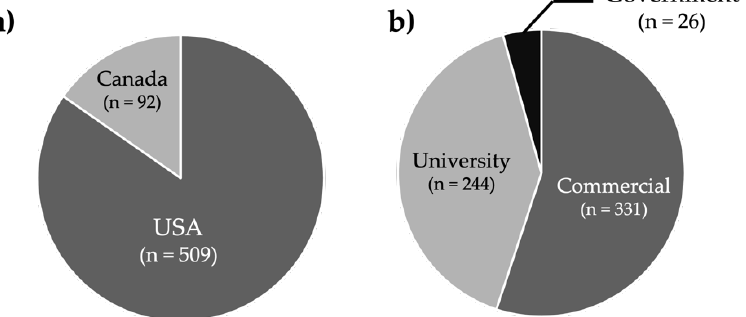
Figure 1. Location and Sector of Identified Companies. ( a ) Of the 601 companies identified, 509 were located in the U.S. and 92 were located in Canada. ( b ) Of the 601 companies identified, 331 were in the commercial sector, 244 were universities, and 26 were governmental organizations.